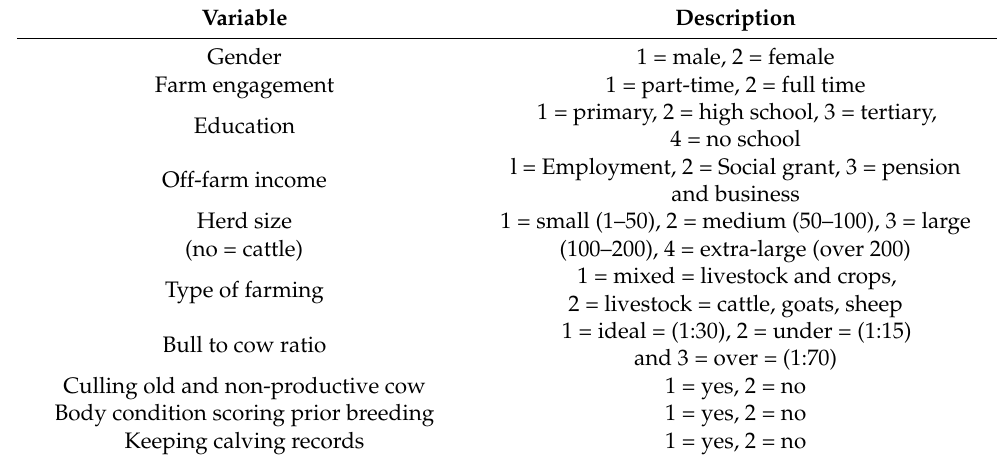
Table 2. Variables included in the regression